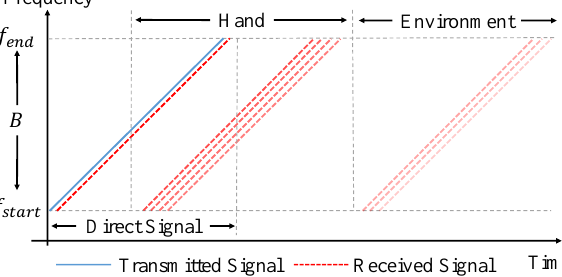
Figure 6. Relationship between time and frequency of the transmitted signal and received signals.